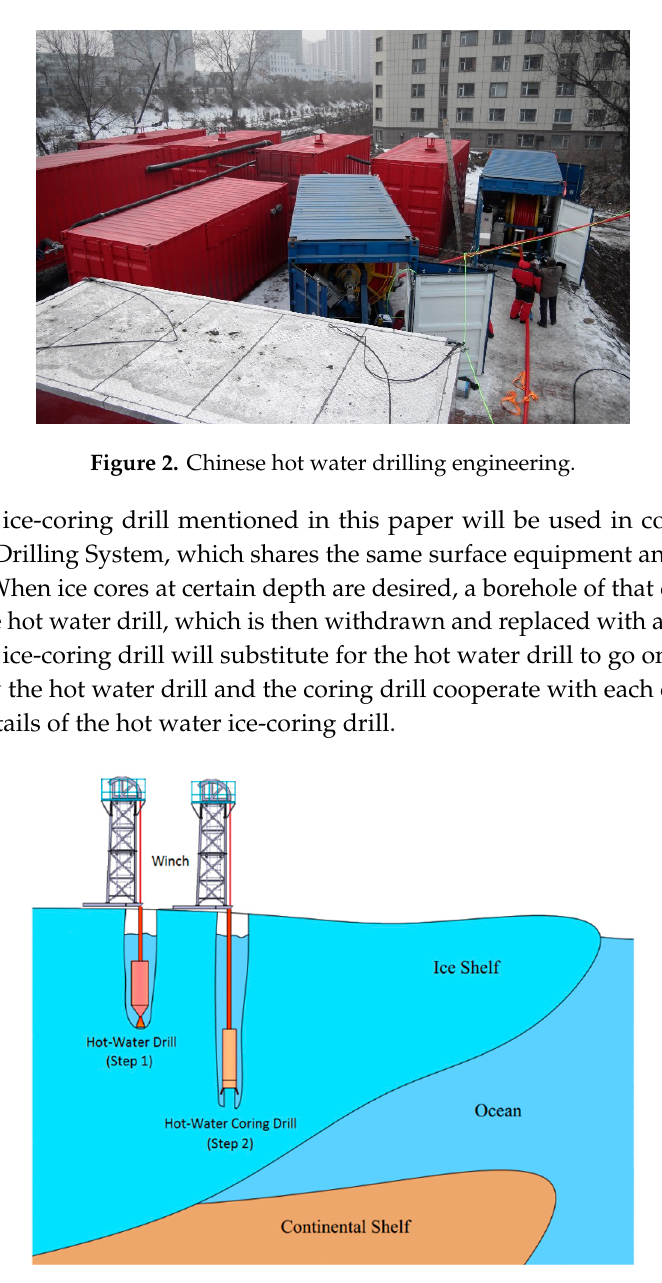
Figure 1. Schematic diagram of the overall hot water drilling system.